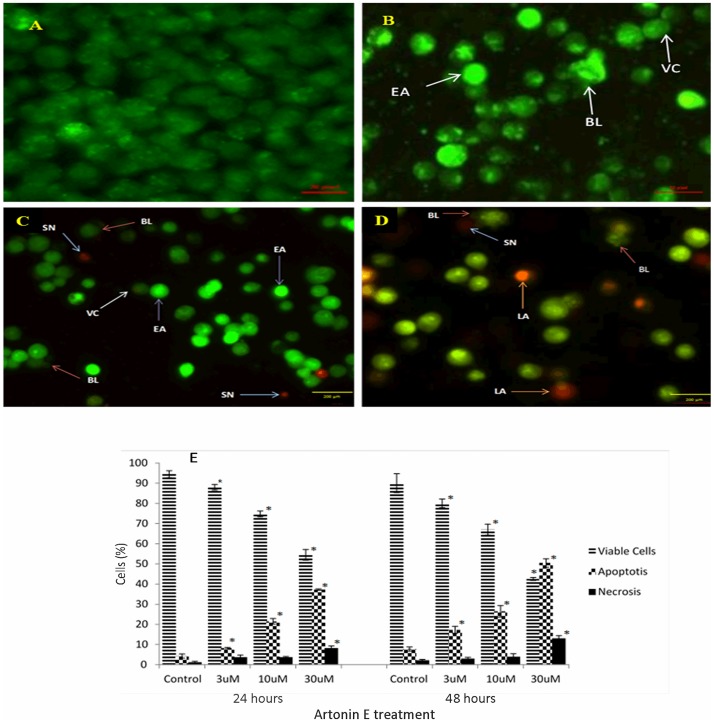
Acridine orange and propidium iodide double staining of MDA-MB 231 breast cancer cells after 24 hour exposure.(A) Control, (B) 3 μM Artonin E. (C) 10 μM Artonin E, (D) 30 μM Artonin E and (E) Quantification of apoptotic morphology at 24 and 48 hours. Each result is presented as mean ± SD of three replicates. * indicates significant difference from the control of each phase (p<0.05). VC = Viable cells; BL = Cell membrane blebbing; CC = chromatin condensation; EA = Early apoptosis; LA = late apoptosis; MN = marginated nuclear chromatin; SN = secondary necrosis. Magnification X200.